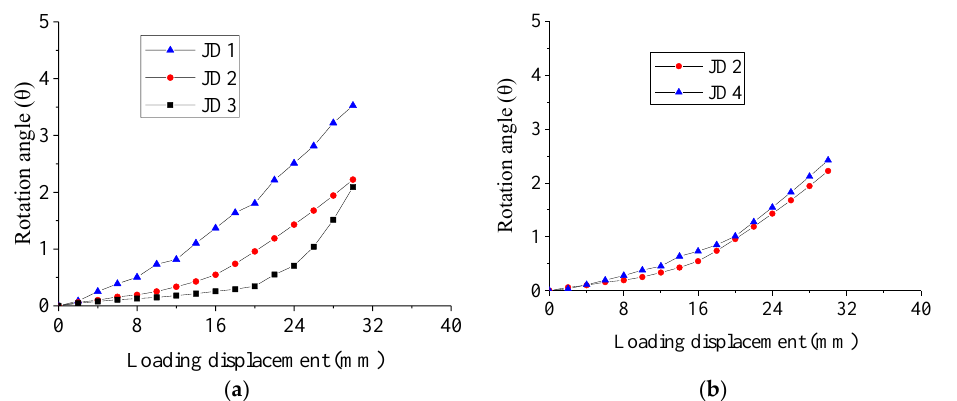
Figure 8. Loading displacement–rotation angle curve of semi-fixed dowel joint. ( a ) Thickness of rubber sleeve. ( b ) Thickness of rubber pad.